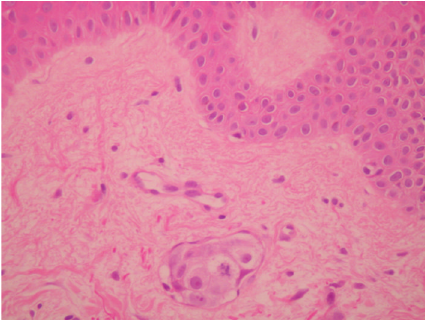
Figure 4: Focus of dermal lymphatic invasion with a mitotic